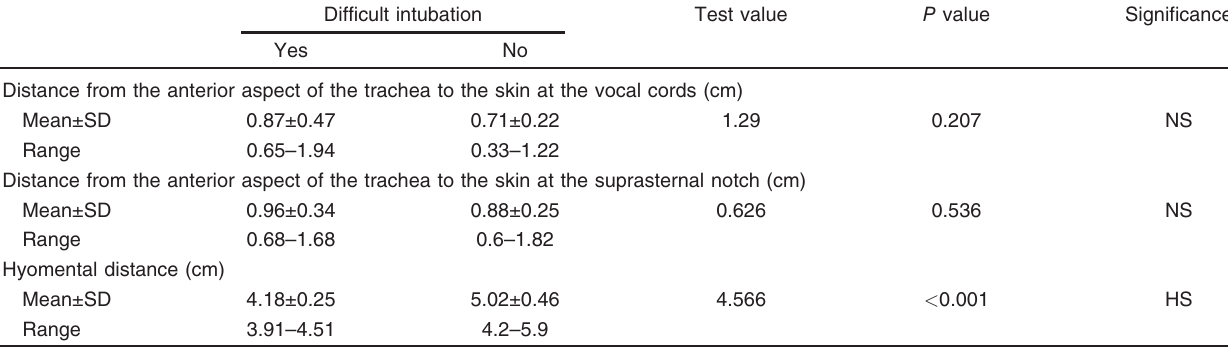
Table 4 Comparison between patients with or without difficult intubation in sonographic predictors of difficult intubation Difficult intubation Test value P value Significance Yes Distance from the anterior aspect of the trachea to the skin at the vocal cords (cm) Mean±SD Range